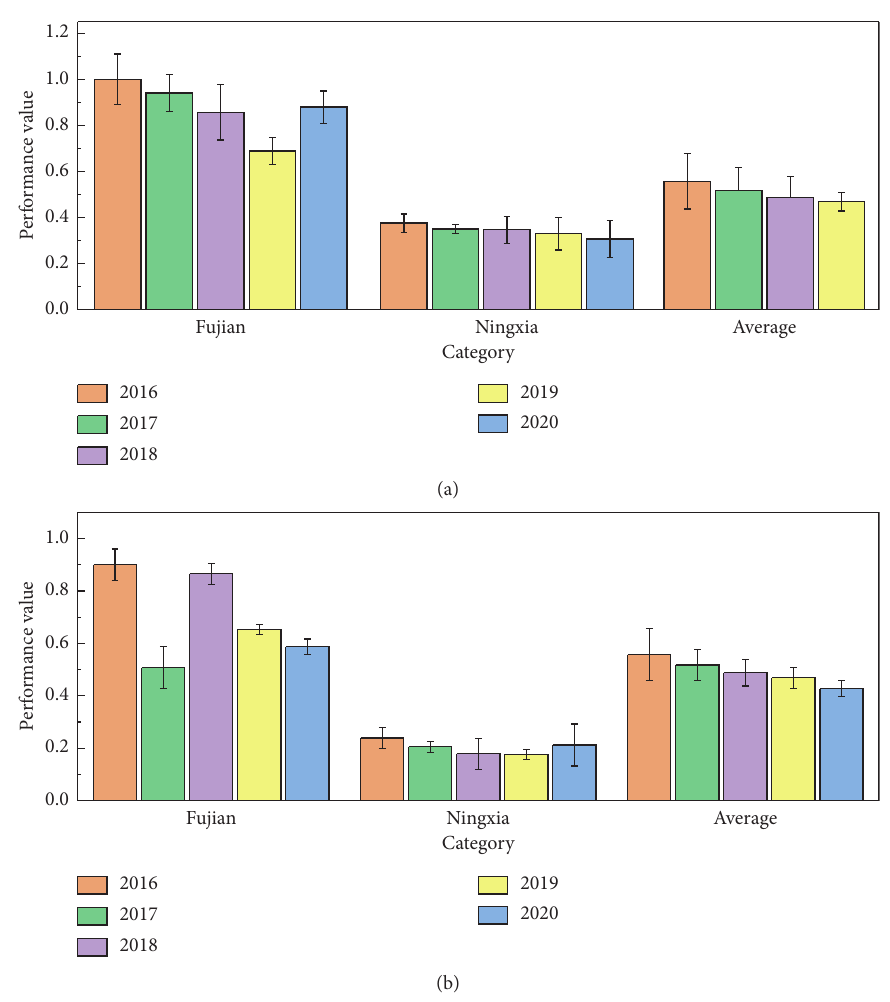
Figure 3: Comparison of performance differences in pension insurance systems among different